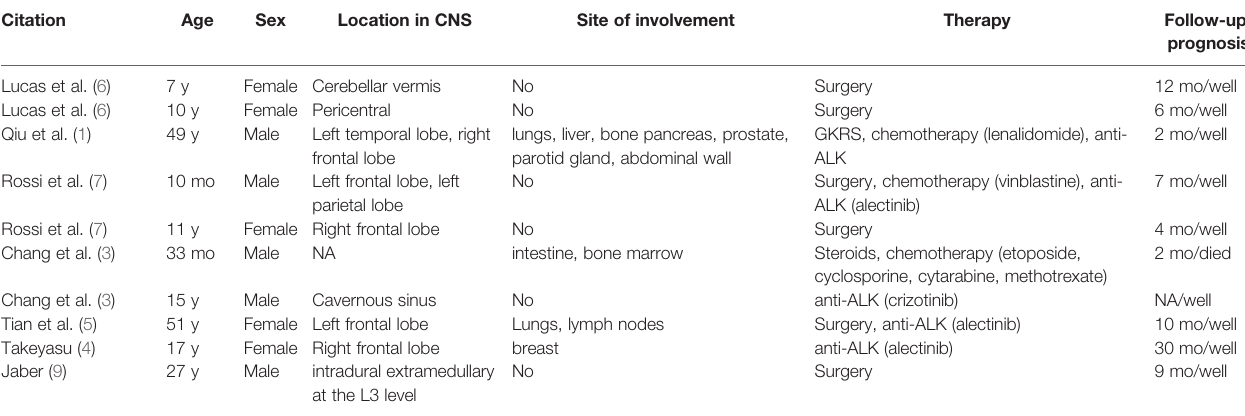
TABLE 1 | Literature search results on the clinical features and outcomes of ALK-positive histiocytosis involving the CNS.